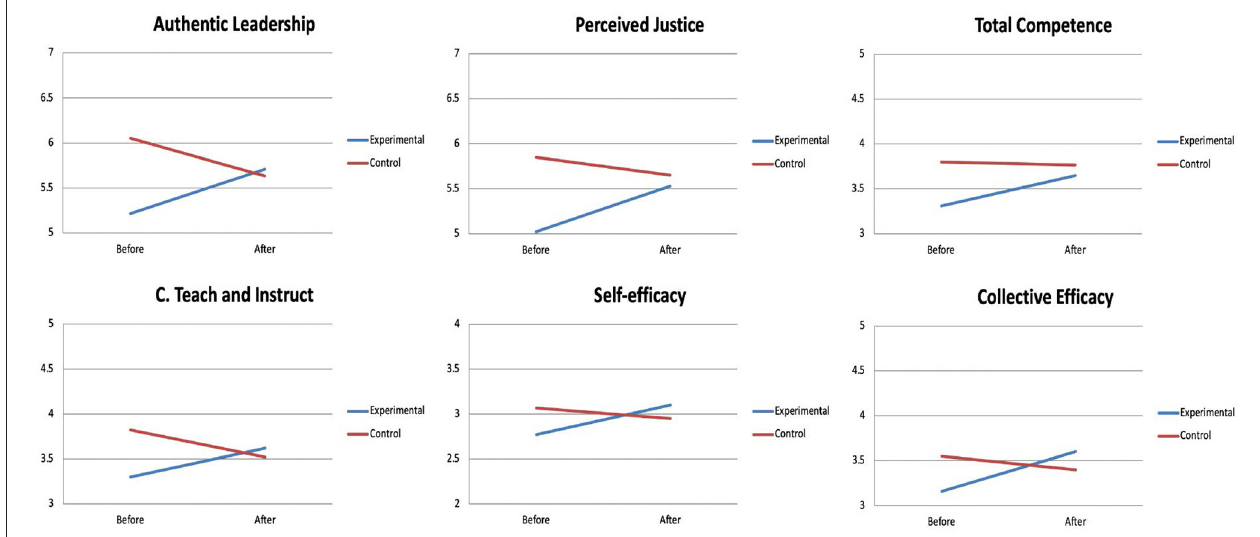
FIGURE 1 | Significant interactions between the time of measure (before vs. after the intervention) and the group (experimental vs. control) for the